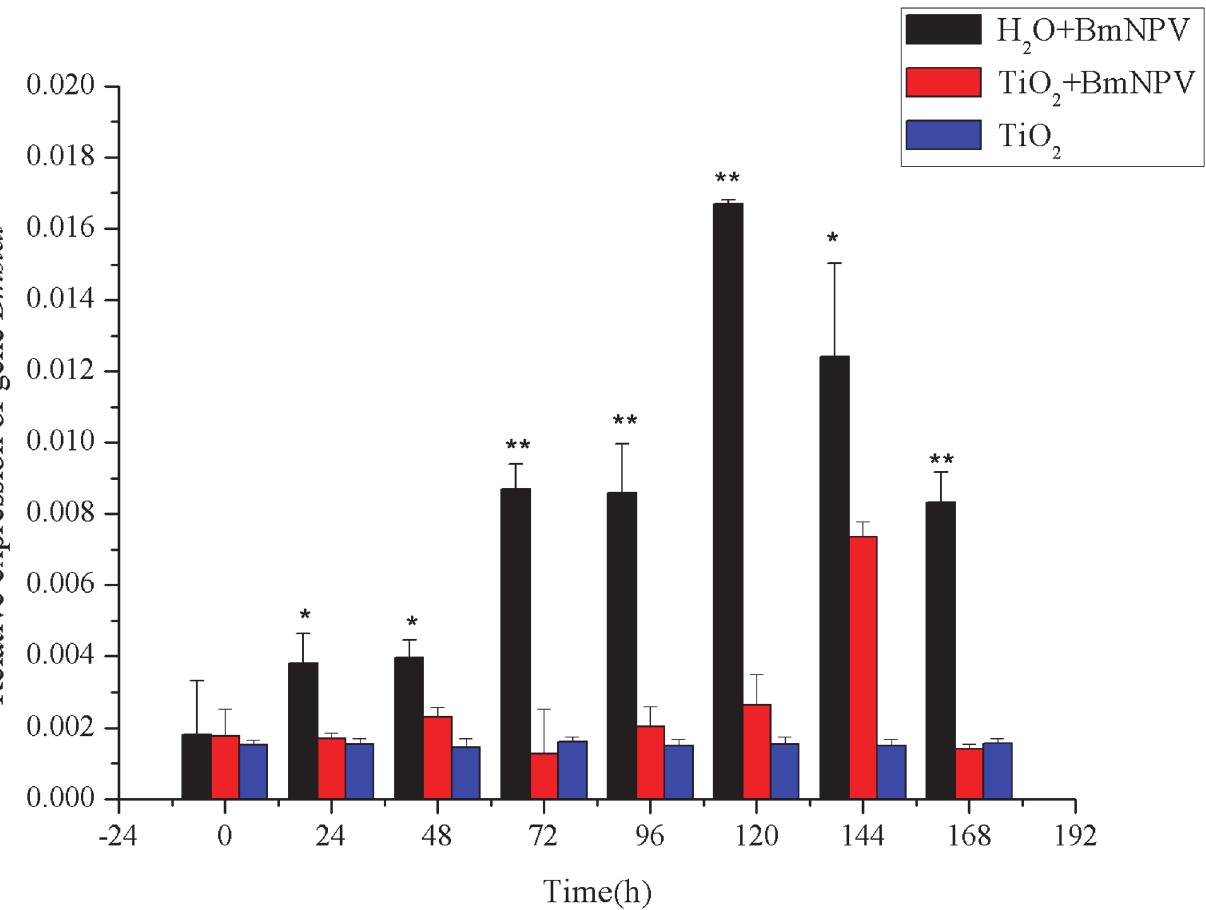
Fig 7. Relative expression of Bmstat . Black and red histograms represent the control group and the experimental group, respectively, and blue histograms represent the TiO 2 NPs-treated group. X and Y axes represent the time after infection and the relative expression of Bmstat , respectively. The bars in the figure with different letters indicate statistically significant differences ( p <